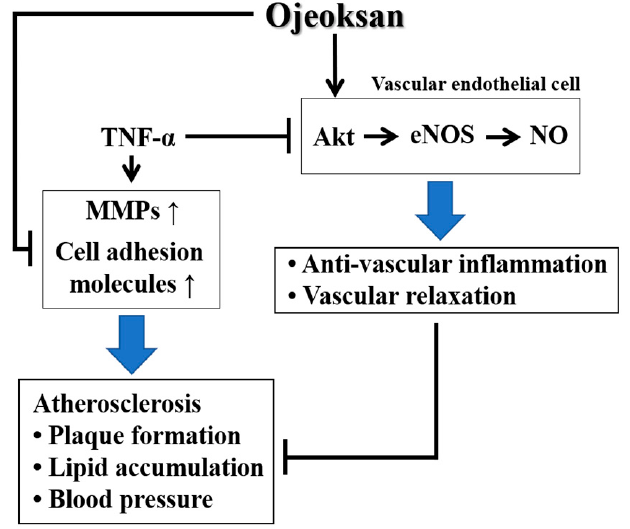
Figure 9. Schematic diagram of the effects of OJS in atherosclerosis.